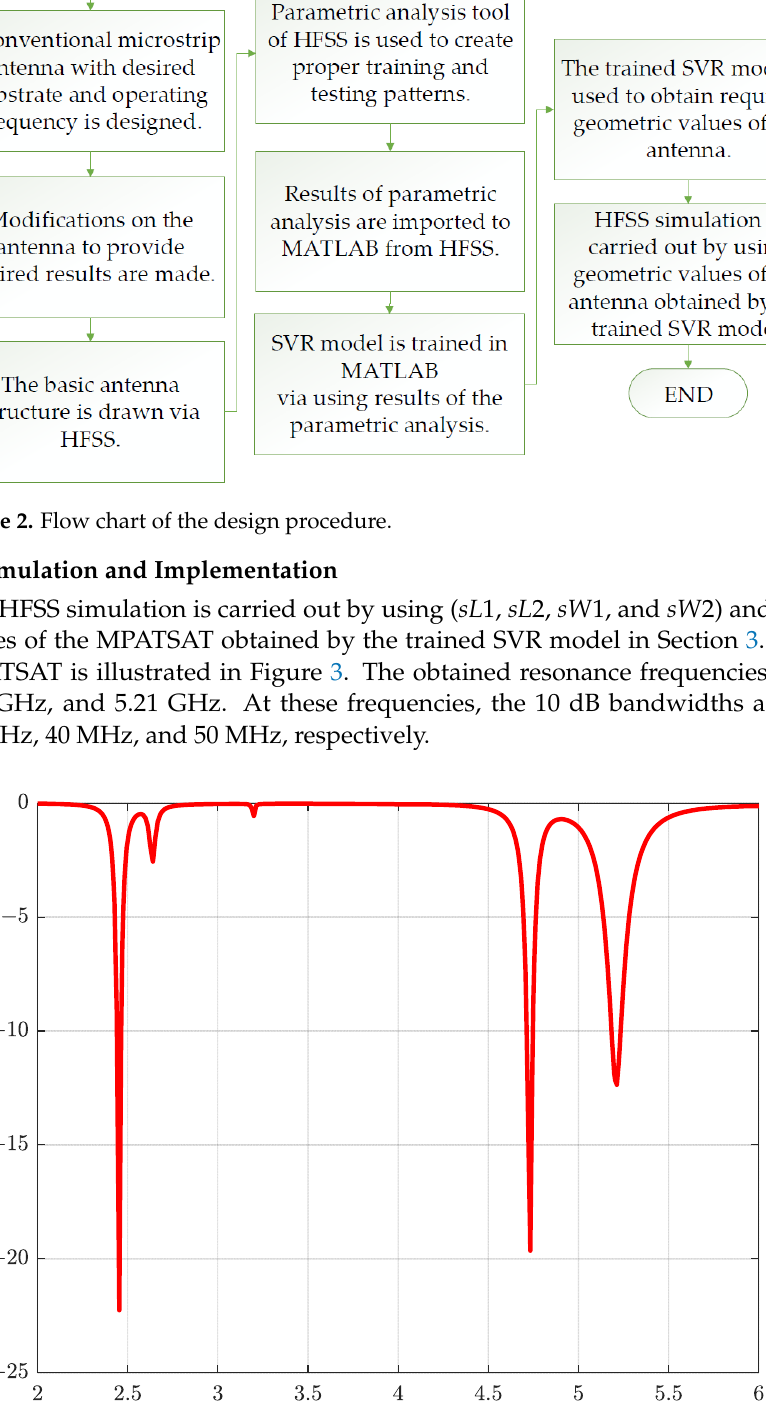
Figure 3. |S11| plot of MPATSAT. Three ‐ dimensional realized gain diagrams of MPATSAT for 2.45 GHz, 4.73 GHz, and 5.21 GHz are shown in Figure 4a–c, respectively. The maximum realized antenna gains are obtained as 6.1 dB, 4.6 dB, and 7.21 dB.